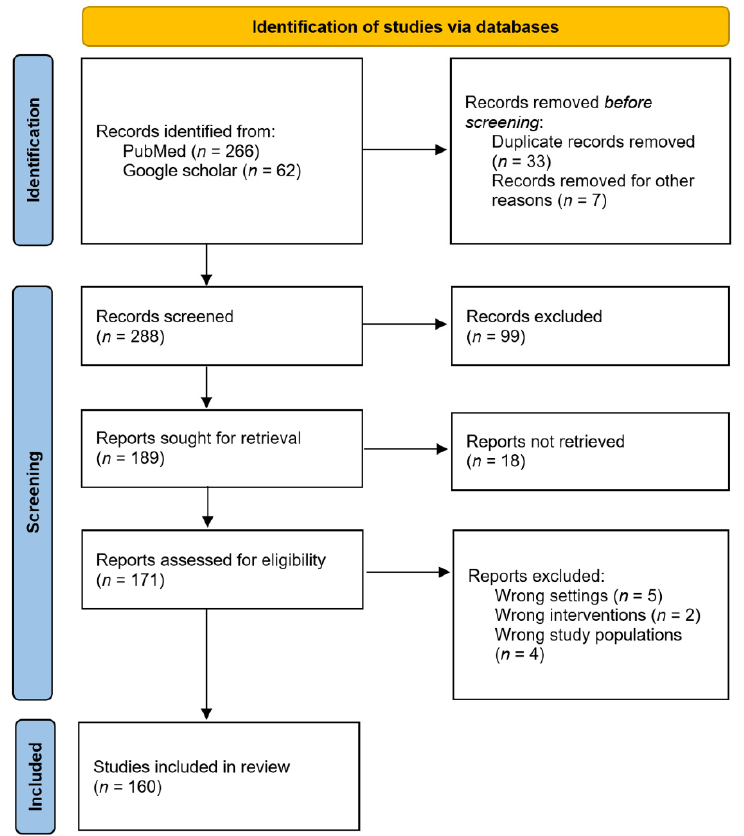
Figure 2. Selection of eligible studies.